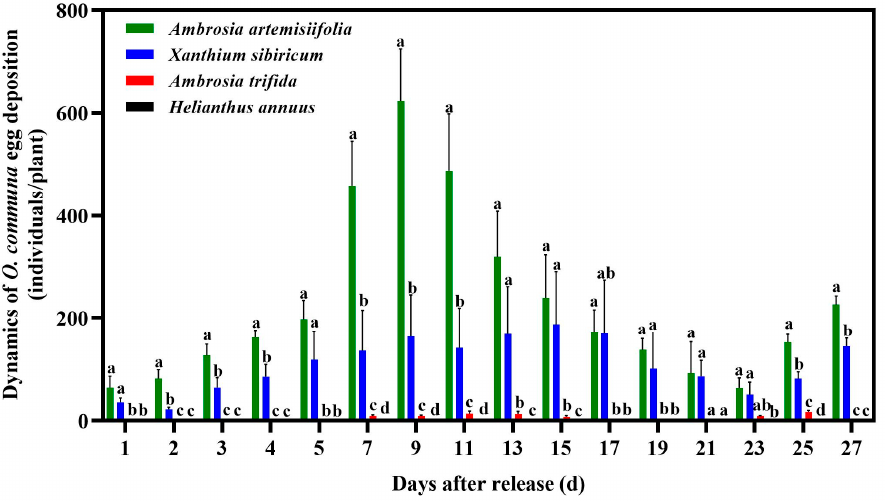
Figure 4. Dynamics of Ophraella communa egg deposition on four coexisting plant species in cage experiments. All values are shown as the means ± SE. Values with the same letter in the same day are not significantly different (three-way ANOVA followed by Tukey test at p ≤ 0.05).